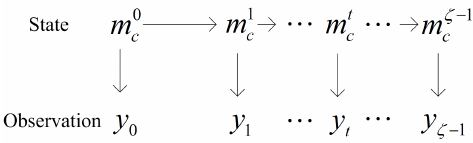
Figure 2. HMM for one